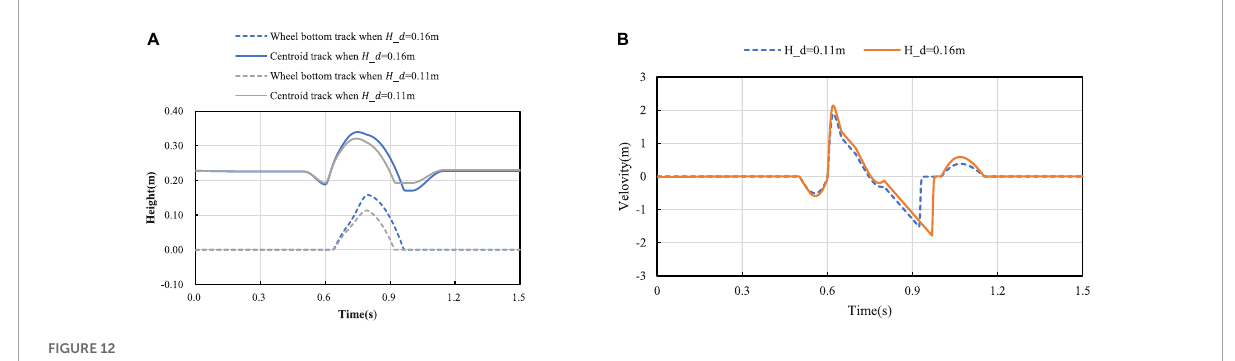
FIGURE12 Jump process curve: (A) Position curve; (B) Vertical velocity curve.